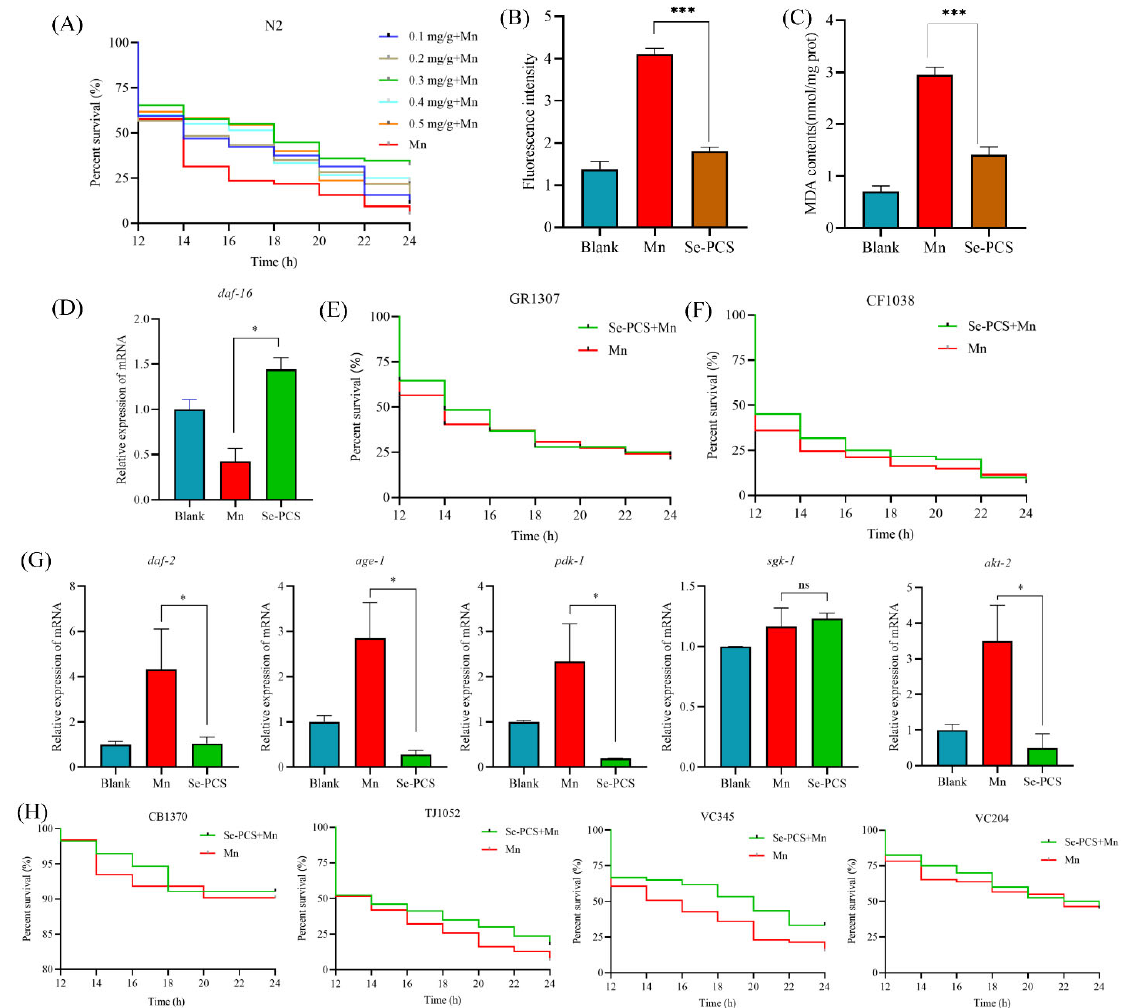
Figure 7. The effects of Se-PCS on C. elegans : ( A ) the survival of wide-type worms under exposure to MnCl 2 (70 mM); ( B ) the ROS level and ( C ) the content of MDA in wide-type worms; ( D ) the expression of daf-16 gene in wide-type worms and the survivals of two strains that missed daf-16 gene—( E ) GR1307 worms and ( F ) CF1038 worms; ( G ) the expressions of genes in insulin signaling pathway including daf-2 , age-1 , pdk-1 , sgk-1 , and akt-2 ; ( H ) the survivals of mutants in insulin signaling pathway including CB1370, TJ1052, VC345, and VC204; * and *** mean p < 0.05 and p < 0.001, respectively, compared with the Mn group.